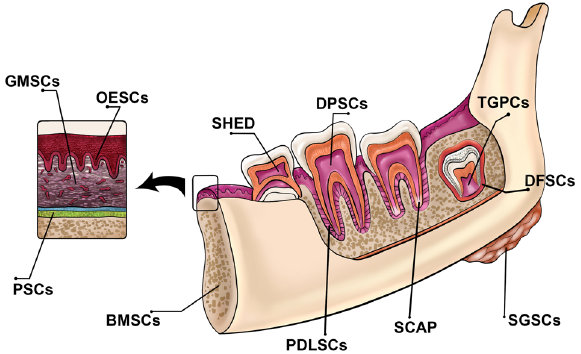
Fig. 1 Adult stem cell sources in the maxillofacial and oral area. DFSCs: dental follicle stem cells; SCAP: stem cells of the apical papilla; OESCs: oral epithelial progenitor/stem cells; SHED: stem cells from human exfoliated deciduous teeth; BMSCs: bone marrow- derived MSCs from orofacial bone; DPSCs: dental pulp stem cells; PDLSCs: periodontal ligament stem cells; SGSCs: salivary gland- derived stem cells. TGPCs: tooth germ progenitor cells; PSCs: periosteum-derived stem cells; GMSCs: gingiva-derived